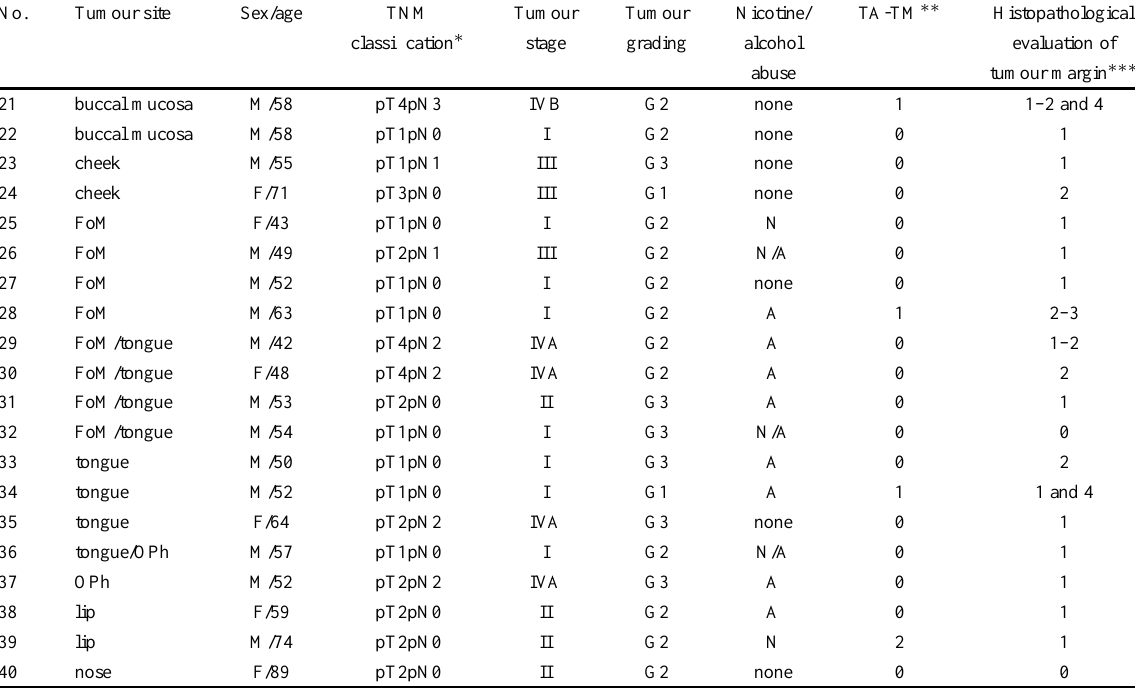
Telomerase activity (TA) of carcinoma-free samples from tumour margin of 20 patients with head-and-neck squamous cell carcinoma and the clinical and histopathological